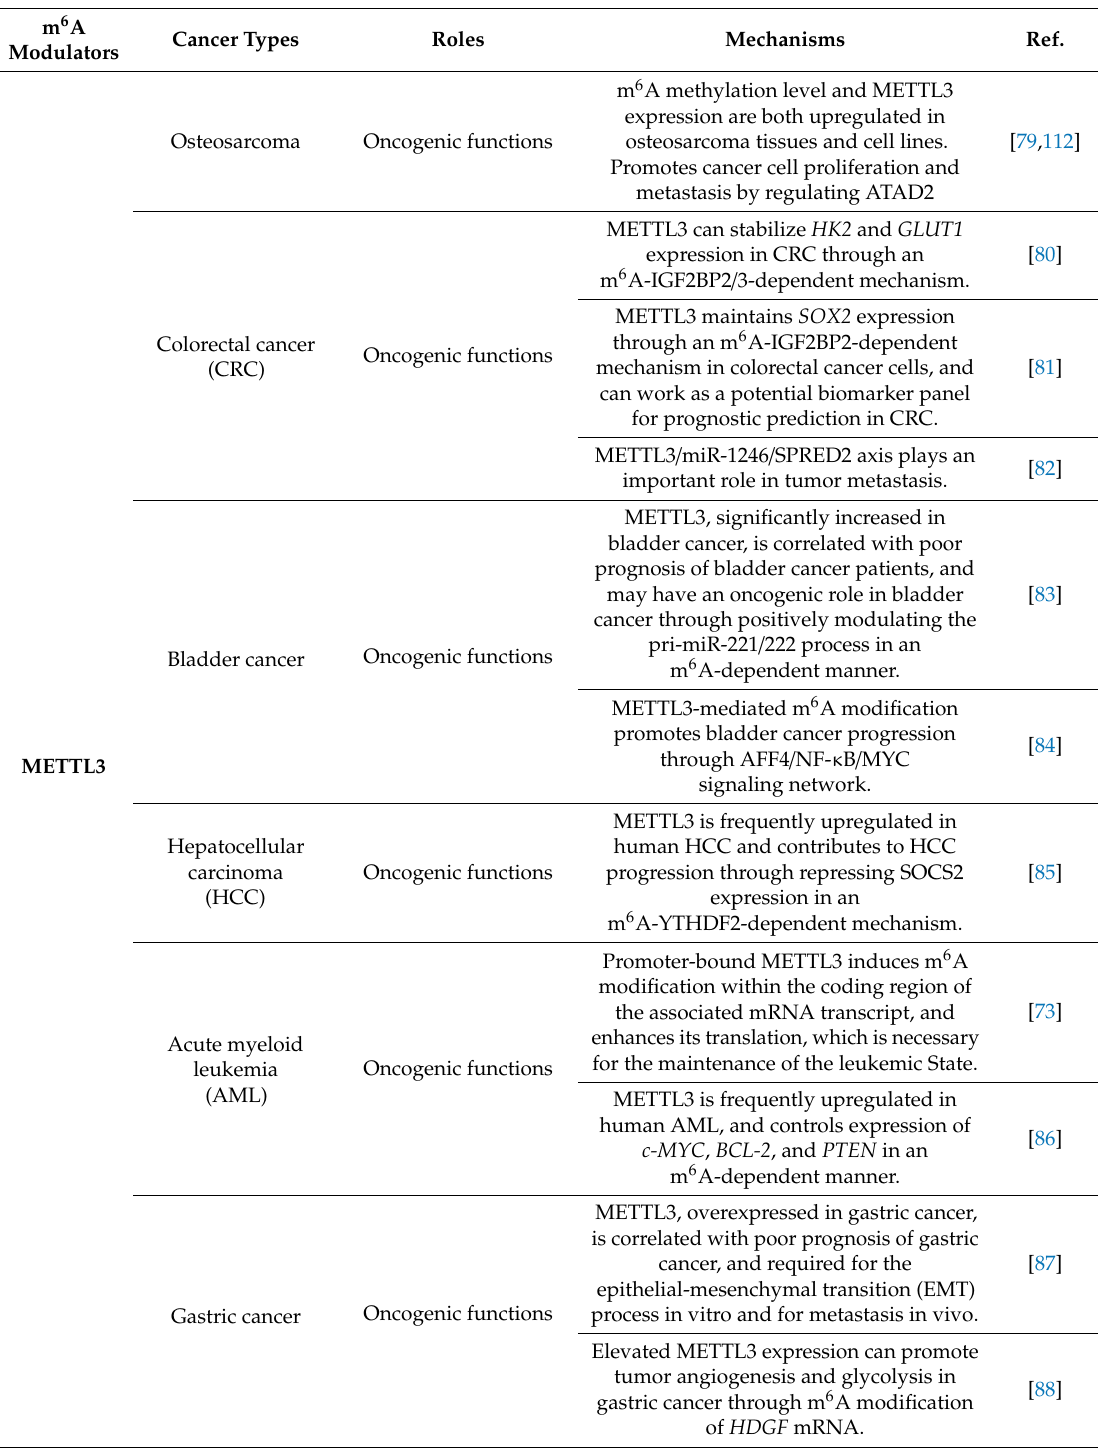
Table 1. The role and mechanisms of m 6 A modulators in human